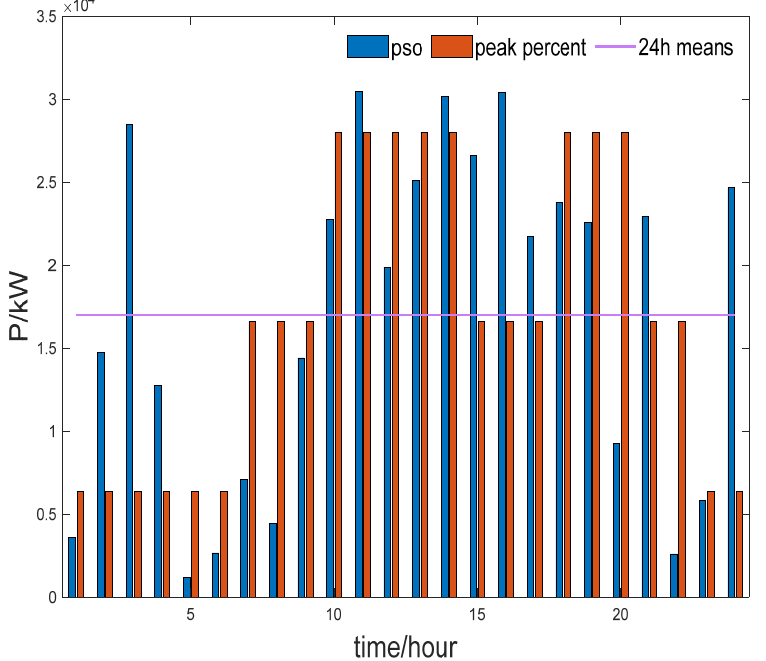
Figure 19. Three decomposition strategies of the load curve in the DA market.